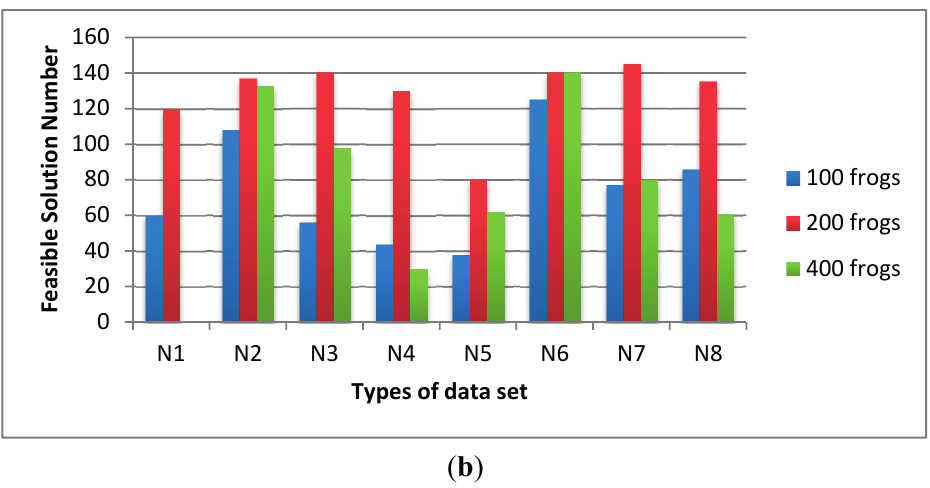
Figure 6. The influence of population size on ( a ) average time and ( b ) feasible solution number.